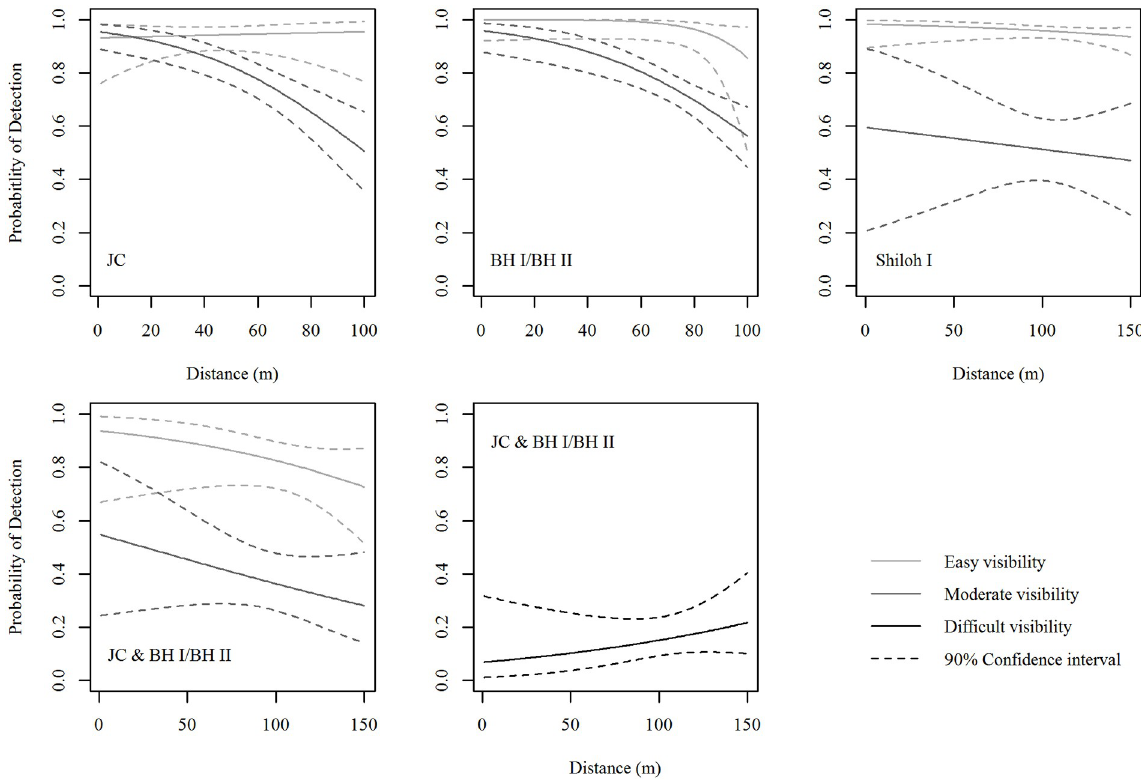
Fig 5. Decoy detection within visibility classes at the Juniper Canyon, Big Horn I/Big Horn II, and Shiloh I wind facilities. https://doi.org/10.1371/journal.pone.0208700.g005 Carcass persistence. We used carcass persistence rates to adjust carcass counts for removal bias. In our study, raptor carcasses persisted substantially longer than game bird car- casses regardless of season, year, or facility. Therefore, game birds do not accurately represent persistence of eagle carcasses because utilizing game bird persistence data would consistently underestimate carcass persistence of medium and large raptors (Table 10). This disparity results in much lower overall probabilities of detection using game birds (0.12 to 0.65) instead of raptors (0.50 to 0.82), even when modeling shorter search intervals (15 days) at facilities with higher searcher efficiency rates (Table 11). Our results for game bird persistence are con- sistent with a recent study in Scotland [29], which found an average probability of persisting through a 30-day search interval of 0.98 for common buzzard ( Buteo buteo ) carcasses and 0.26 Table 6. Searcher efficiencies a for the different studies at the Juniper Canyon (JC), Big Horn I (BH I), Big Horn II (BH II), and Shiloh I wind energy facilities.